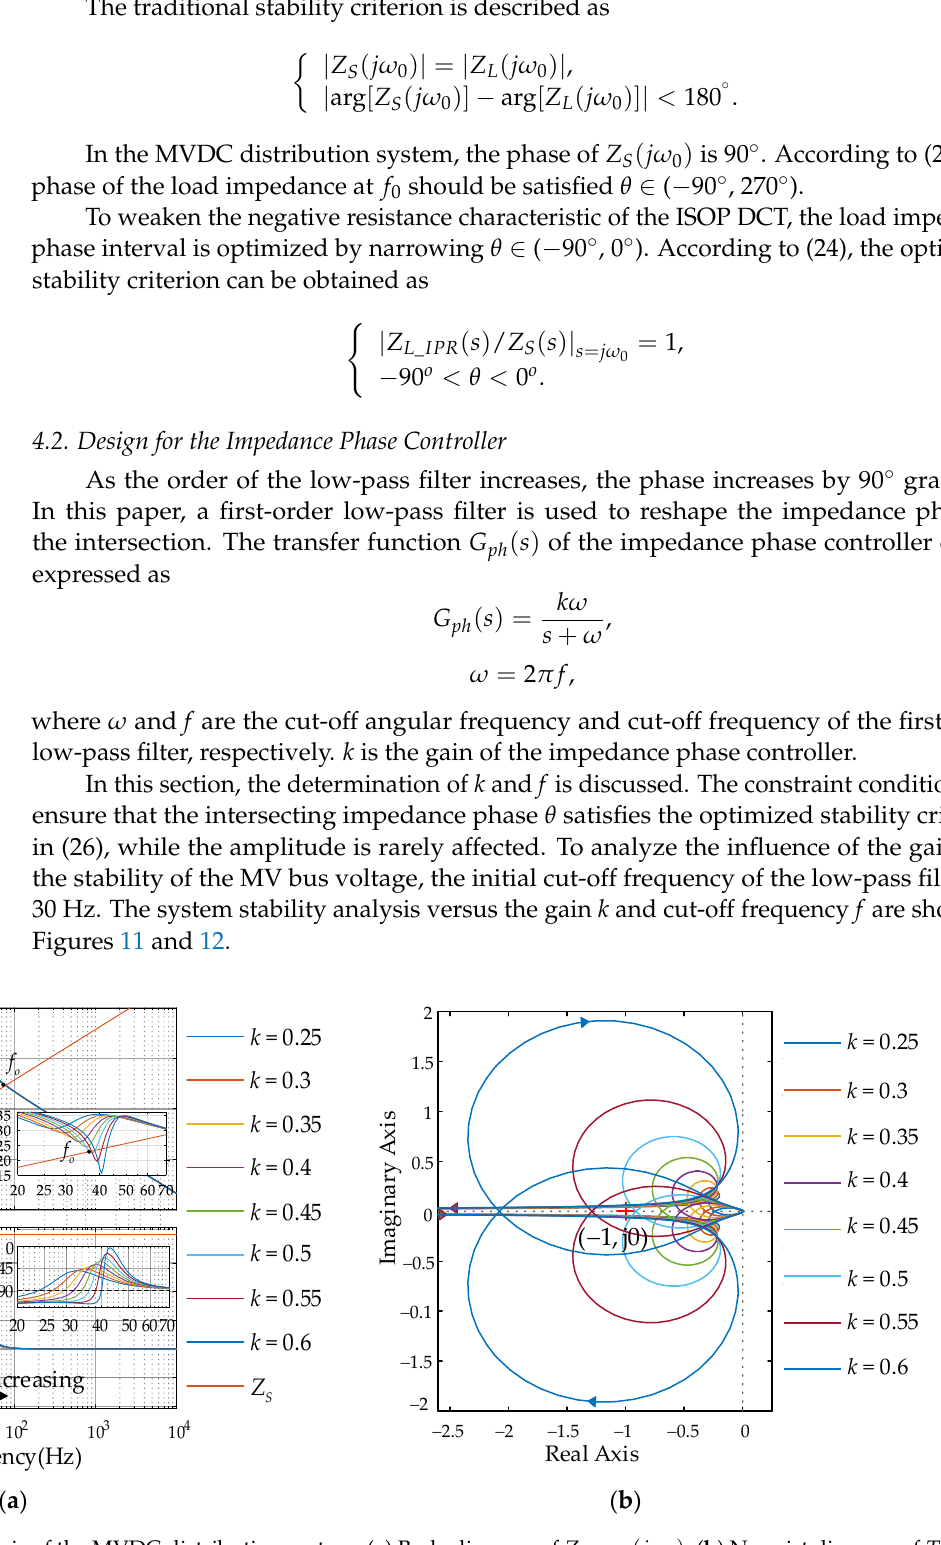
(j ) L_IPR Z ω , ( b ) Nyquist diagram of 0